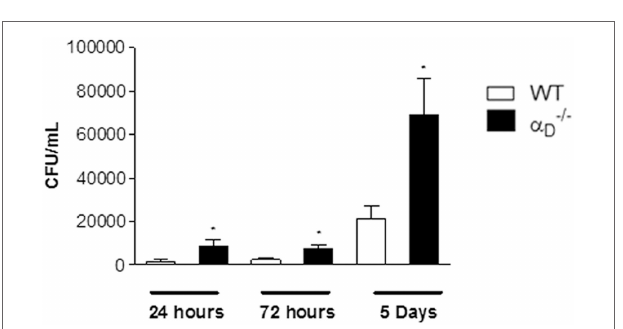
FIGURE 2 | Targeted deletion of integrin α D β 2 leads to a defect in peritoneal killing of Salmonella Typhimurium. Wild-type (WT) and α –/– D mice were infected with S . Typhimurium (10 5 CFU/animal) by intraperitoneal injection or were sham-infected with sterile, apyrogenic saline as in Figure 1 . Peritoneal fluid was collected 24h, 72h, or 5days later, and the number of colony-forming units was determined in each sample. Each bar indicates the mean (cid:6) SEM of determinations in samples from five animals. The data in this figure are representative of three separate experiments. Significant differences ( p < 0.05) between infected animals and controls are indicated by asterisks.